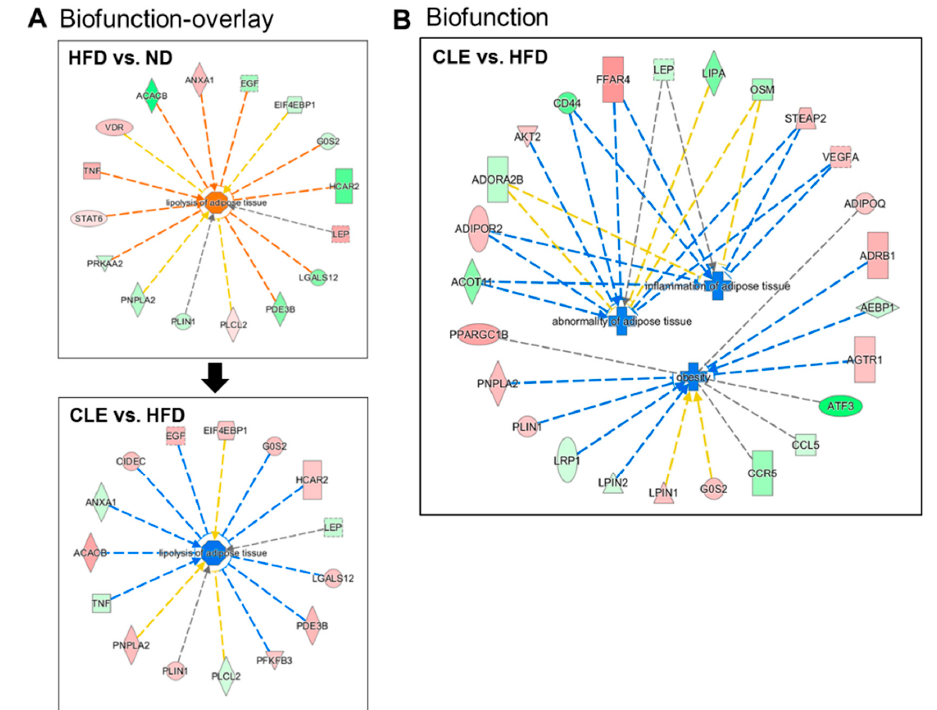
Figure 7. Biofunction analysis of differentially expressed genes from eWAT ( A ) Biofunction-overlay of the disease and function related to lipolysis in eWAT; ( B ) the disease and function in response to CLE in eWAT. Differentially expressed genes based on HFD compared to ND, and CLE and LU compared to HFD comparison for q - < 0.05, fold change > 1.5. ND, normal diet (AIN-76); HFD, high-fat diet (45% kcal from fat); CLE, HFD+chrysanthemum leaf ethanol extract (1.5%, w / w ); LU, HFD+luteolin (0.003% w / w ); eWAT, epididymal adipose tissue. Red indicates upregulation relative to HFD; green indicates downregulation relative to HFD. Orange color indicates activation of biofunction; blue color indicates inhibition of biofunction. Grey nodes indicate input genes into the pathway analysis and the different symbols indicate gene functions. Yellow nodes indicate inconsistent effect with predicted. Cross shape, disease; octagon shape, function; square, cytokine; triangle, phosphatase; horizontal oval, transcription regulator; vertical diamond; enzyme; circle, other.